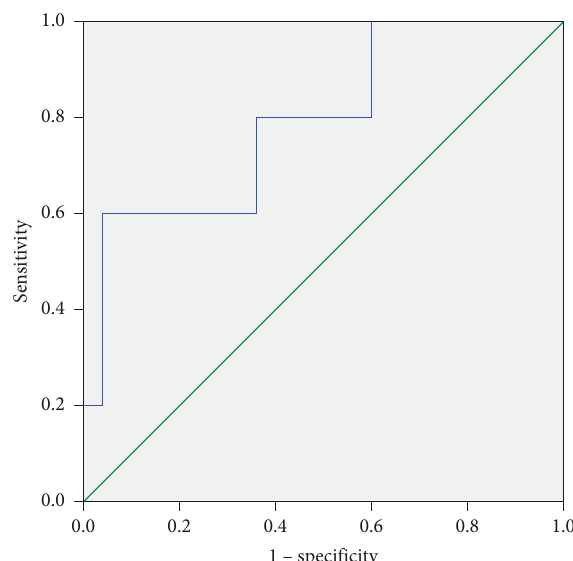
Figure 1: ROC curve for the selected logistic regression model in the diagnosis of residual cancer. Area under the curve � 0.761; sensitivity � 81.3%; specificity � 71.4%.